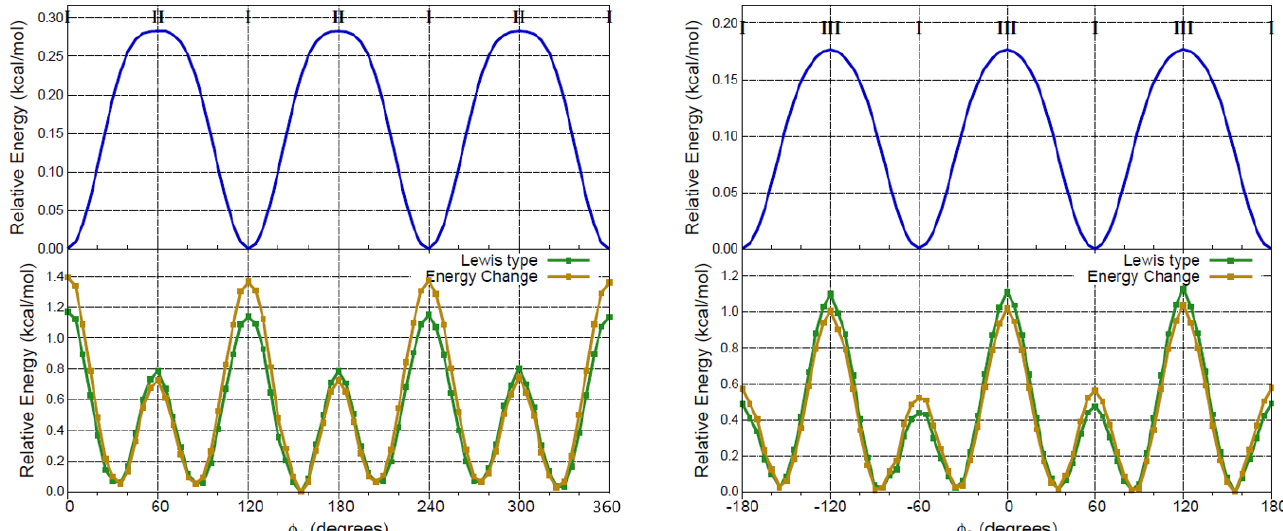
Figure 6. B3LYP–D3/6–311++G( d , p ) energy profiles for the interconversion of I into itself via the two lowest energy barrier paths (see Figure 3). Top : full electronic energy paths. Bottom : deleting all hyperconjugative interactions (green lines) and the associated energy difference with the full electronic energy (golden